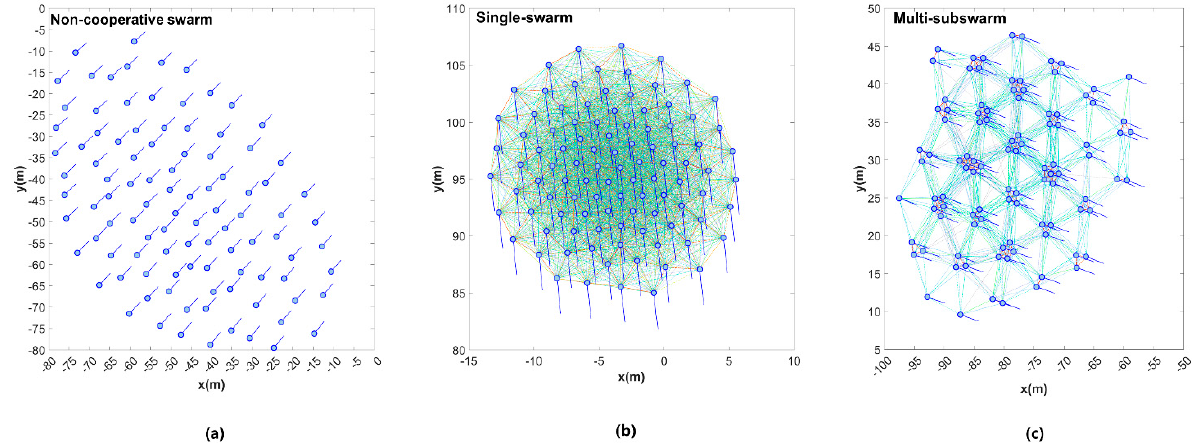
Figure 1. Illustration of three a tt acking pa tt erns in the target − free environment. ( a ) The non ‐ coop ‐ erative swarm attack pattern; ( b ) The single ‐ swarm swarm attack pattern; ( c )The multi ‐ subswarm cooperative swarm attack pattern; ( b ) The single-swarm swarm attack pattern; ( c ) The multi- attack pattern subswarm attack